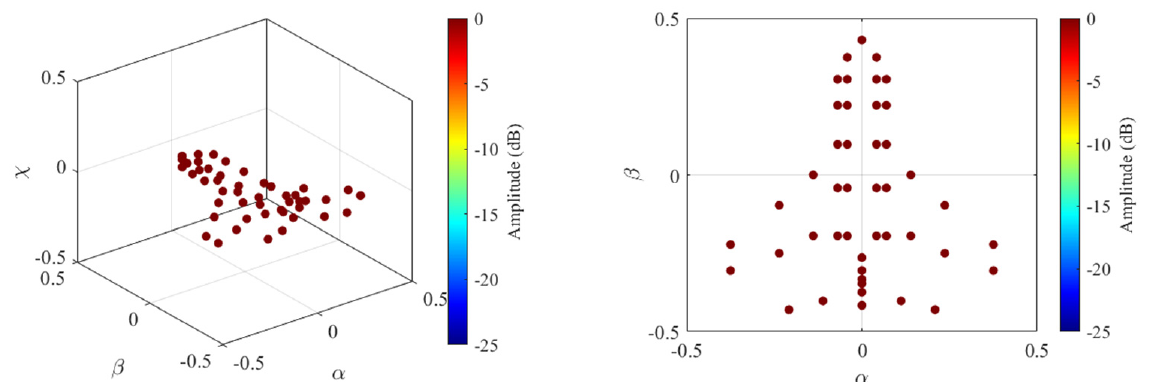
Figure 8. Ground-truth for simulated target imaging.